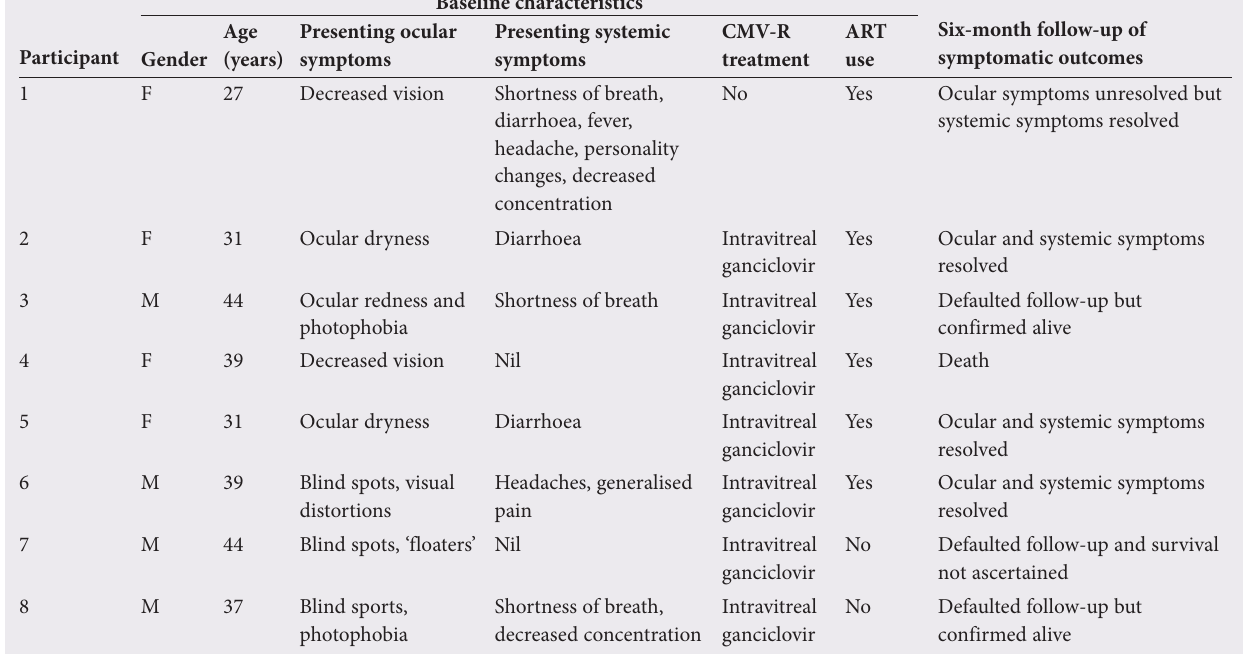
Table 1. Summary of participant characteristics, treatment and symptoms at baseline and 6 months